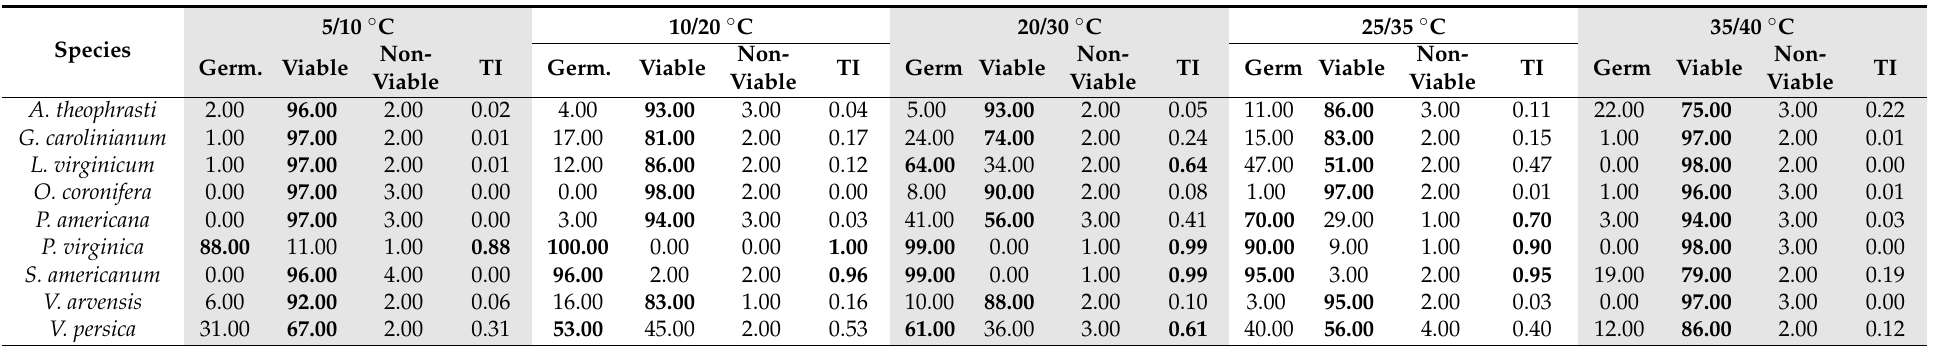
Table 2. Germination percentage in the light treatments, percentage of seeds remaining viable and non-viable by the end of the trials, analyzed under a stereoscope, and thermotolerance index (TI) of the nine invasive species at five different temperature regimes. The thermotolerance index was calculated as described in Material and